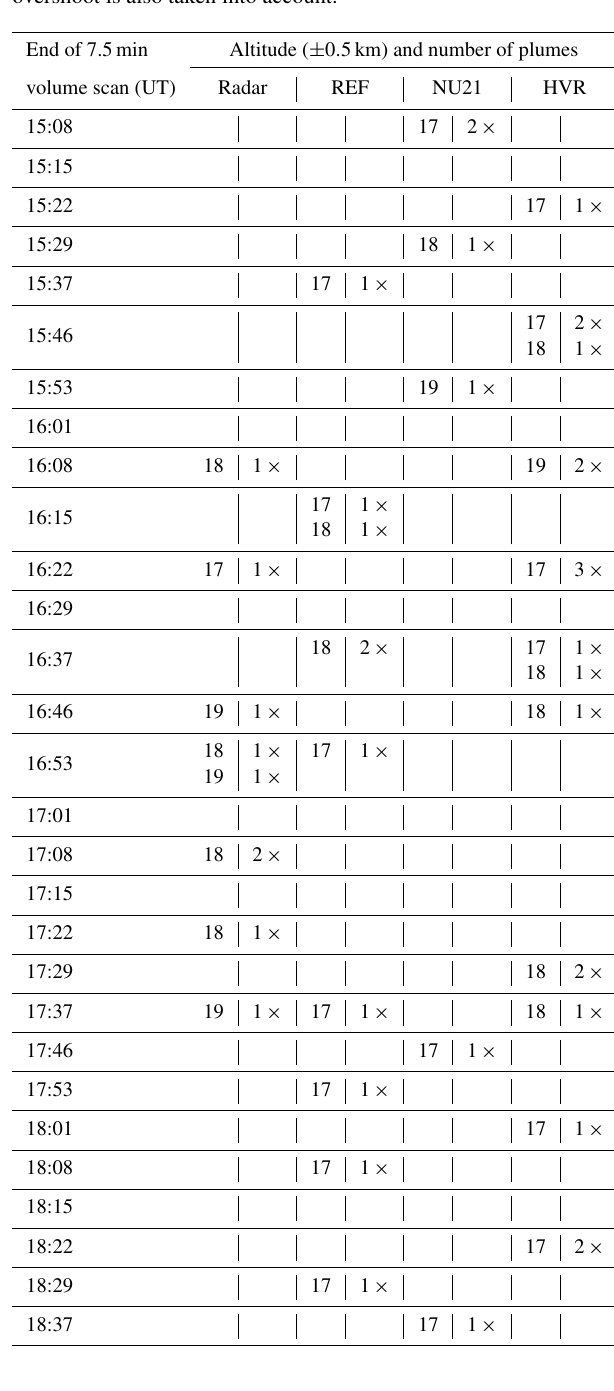
Table 1. Count of overshoots above 17km altitude for the S-band radar (end time UT of the volume scan) and for the REF, NU21, and HVR simulations. Their counts are represented as multiples of × . Within a 1km thick layer, the altitude is the lowest point. The mod- elled overshoots are calculated by taking into account the height of each plume in the 7.5min time-lapse imagery, which must be greater than or equal to 17km, as well as the spatial spread of each plume. Figure 6 depicts a scenario in which the spatial extent of the overshoot is also taken into